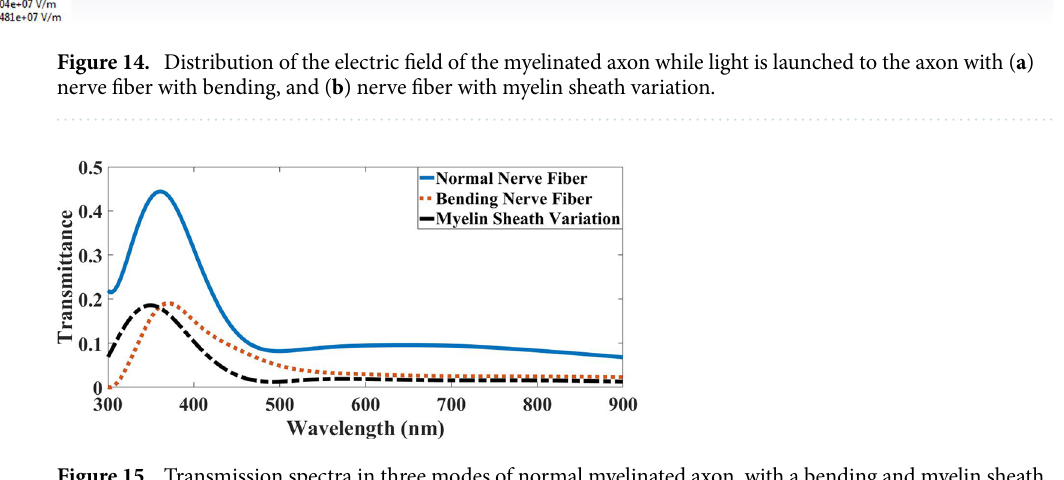
Figure 15. Transmission spectra in three modes of normal myelinated axon, with a bending and myelin sheath variation, while light is launched to the axon.